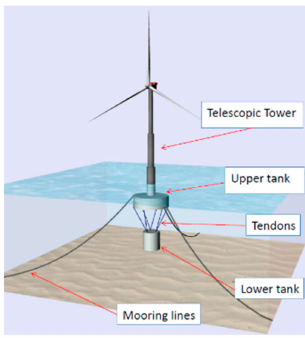
Figure 4. Main parts of the Telewind ® structure. Source: Figure courtesy of Esteyco [23–25].